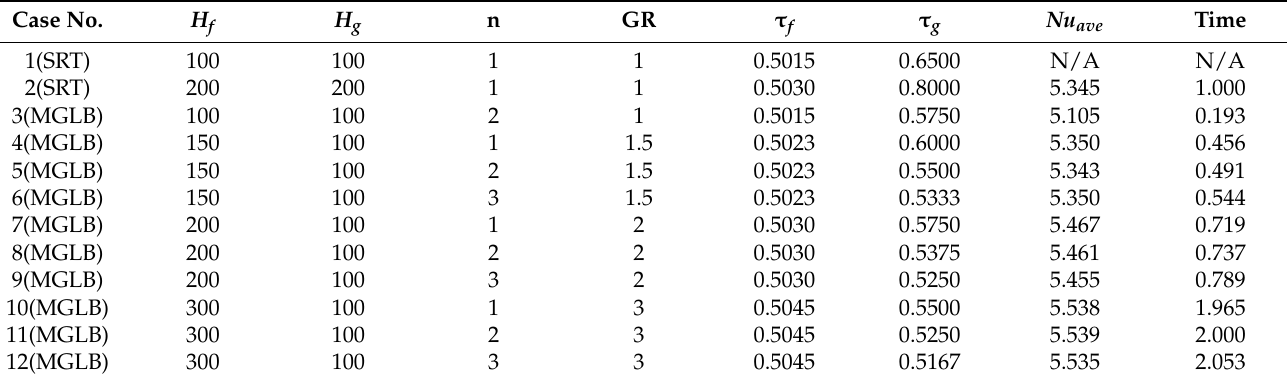
Table 4. Input parameters and simulation results for Ra = 10 6 , Pr = 0.01 for simulations with single relaxation time (SRT) (Cases 1 and 2) and multiple-grid lattice Boltzmann (MGLB) (Cases 3 to 12). “N/A” indicates no convergence. The characteristic velocity was selected as u c = 0.05 in all cases. The Time column is normalized by Case 2. The average Nu number from SRT-LB simulations presented in Section 3.2 was 5.312. Case